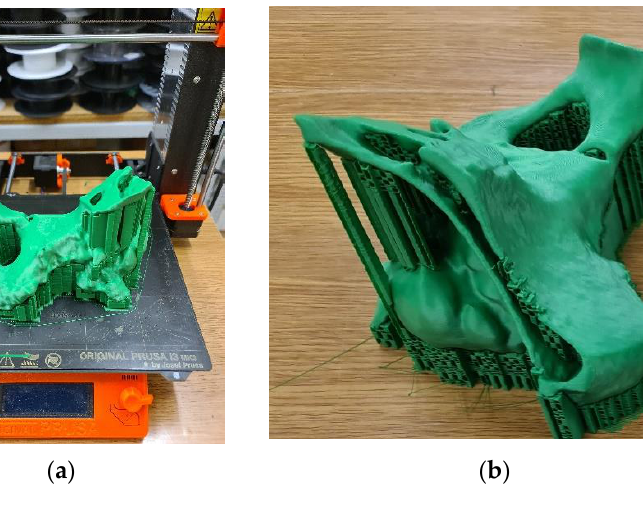
Figure 10. Model of the anatomical structure: ( a ) Situated within the working space of 3D printer; ( b ) After detaching from the working platform; and ( c ) Following the removal of the supporting structure.